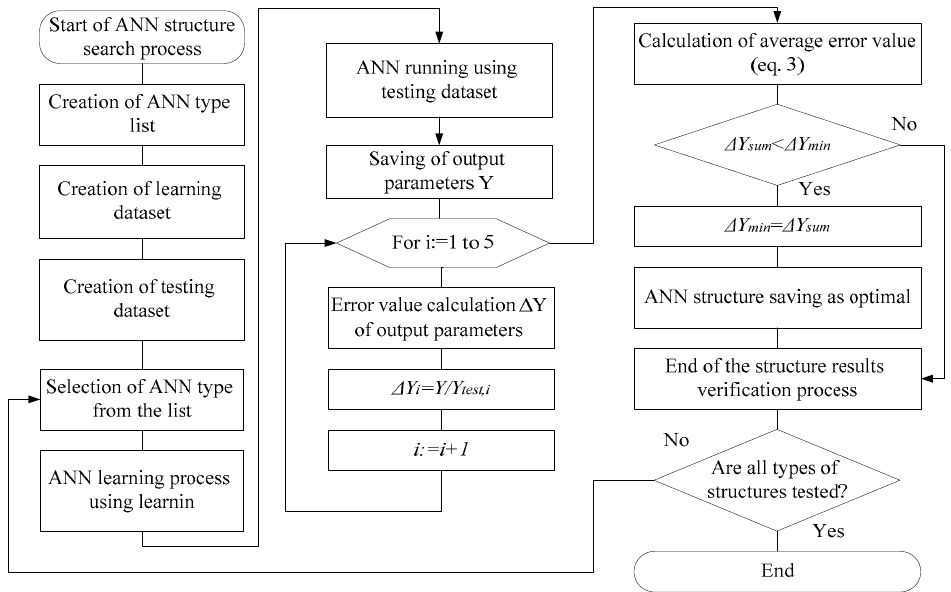
Figure 2. An algorithm of the method for the selection of the optimal type of neural network.